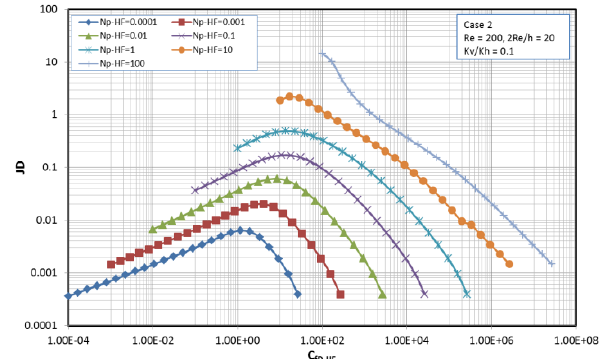
Figure 7—Case 1 with x